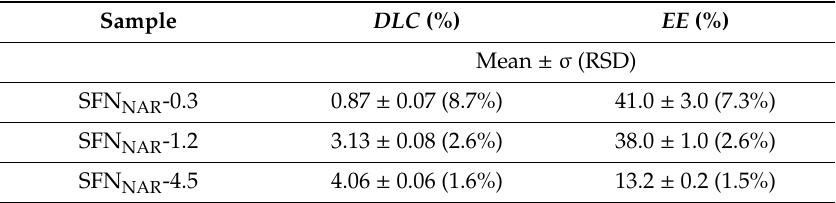
Table 4. Drug loading content ( DLC ) and entrapment e ffi ciency ( EE ) of NAR-loaded SFN are expressed as mean ± standard deviation. n =